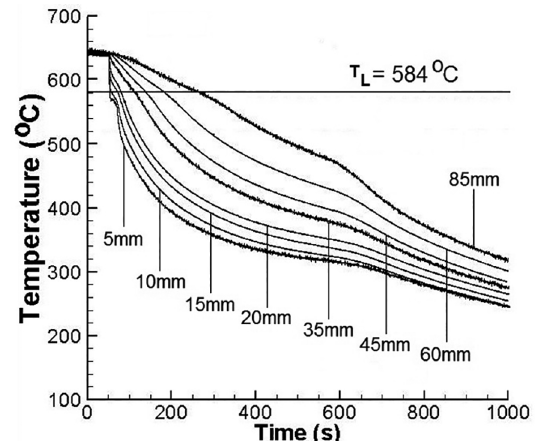
Figure 3. Experimental cooling curves for a ternary Al-9.0wt%Si- 4.0wt%Cu alloy at different vertical positions (5, 10, 15, 20, 35, 45, 60 and 85mm).